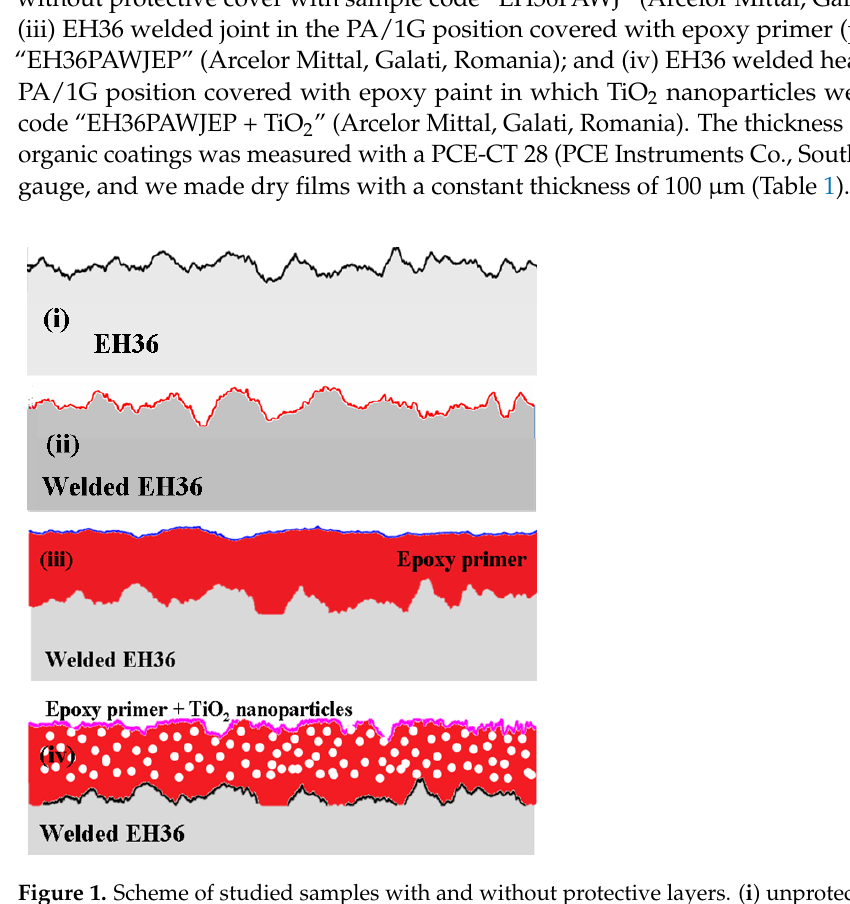
Table 1. Samples used for corrosion resistance evaluation.